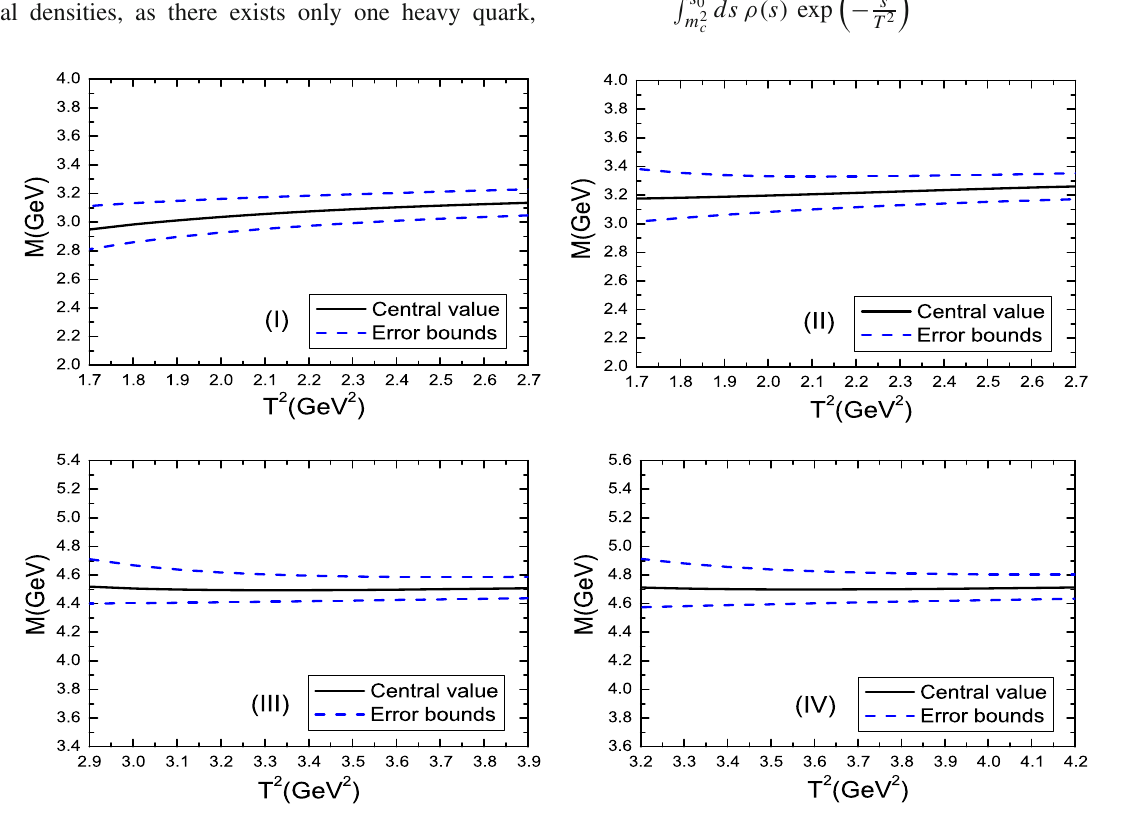
Fig. 2 The masses of the charmed pentaquark states with variations of the Borel parameters T 2 for the parameters A , where the (I), (II), (III) and (IV) correspond to the quantum numbers ( uuuc ¯ u , 3